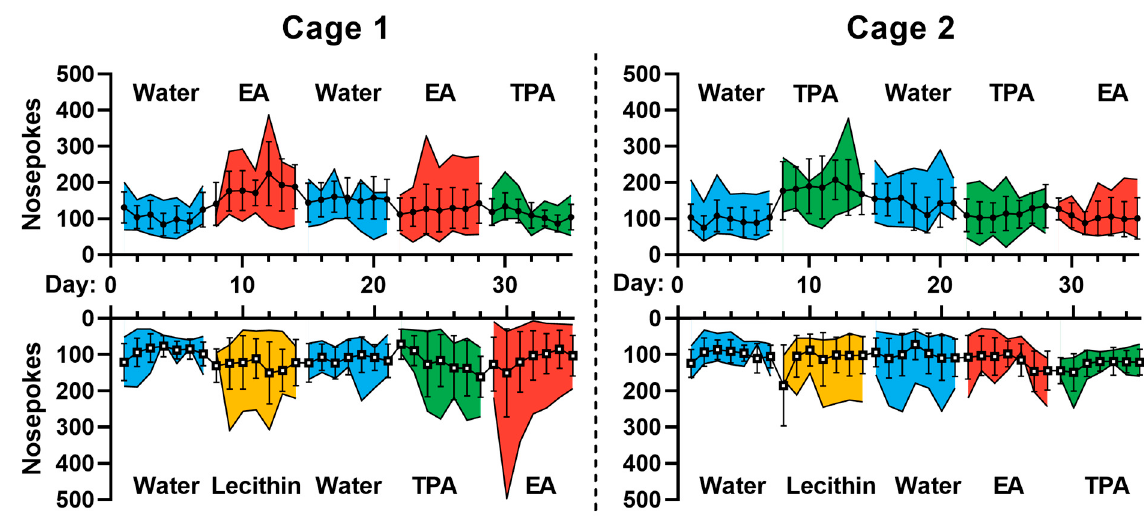
Figure 4. The activity of the mice based on the number of nose pokes. Data represent means ± SD. For each cage the graph on the top represents corner 1 and 3 and the one at the bottom represents corner 2 and 4. The activity of mice remains constant over 5 weeks as mice had approximately 100–200 nosepokes per day, in each corner.